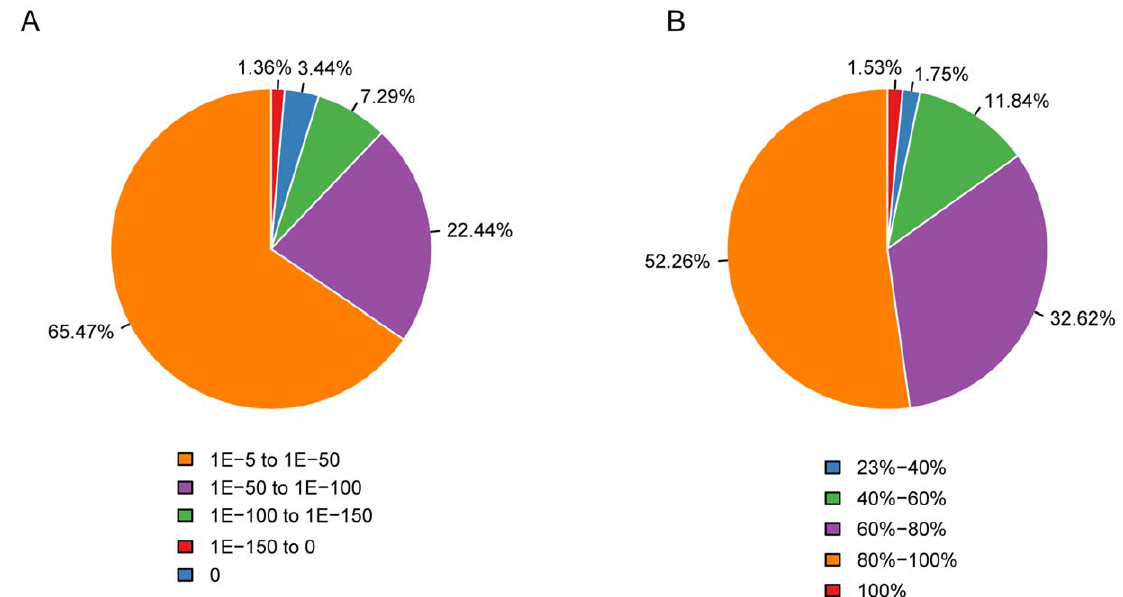
Figure 2. Characteristics of sequence homology of D.latiflorus unigenes BLASTED againsta GenBank databases. A. E-value distribution of BLAST hits for matched unigene sequences, using an E-value cutoff of 1.0E-5. B. Identity distribution of top BLAST hits for each unigene.